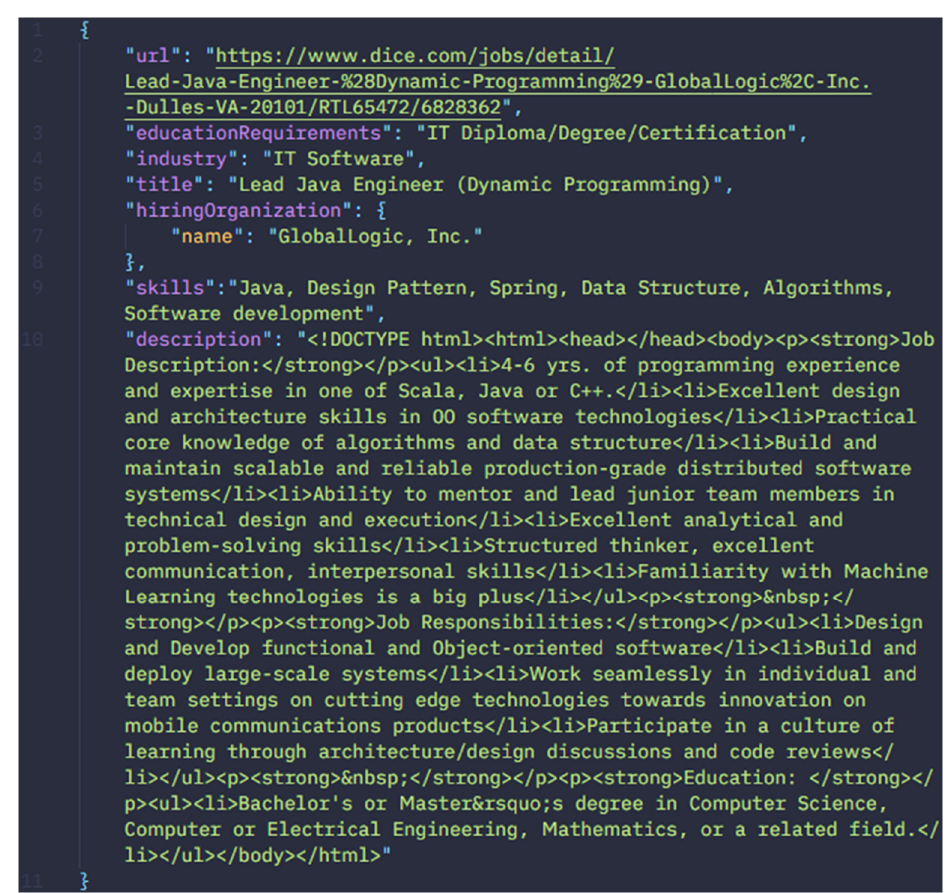
Figure 5. Sample job advertisement on a job portal www.dice.com (20 March 2021).